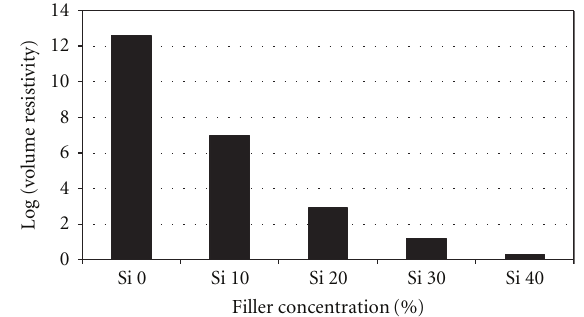
Figure 5: Dependence of volume resistivity ( Ω · m) on filler concen- tration.